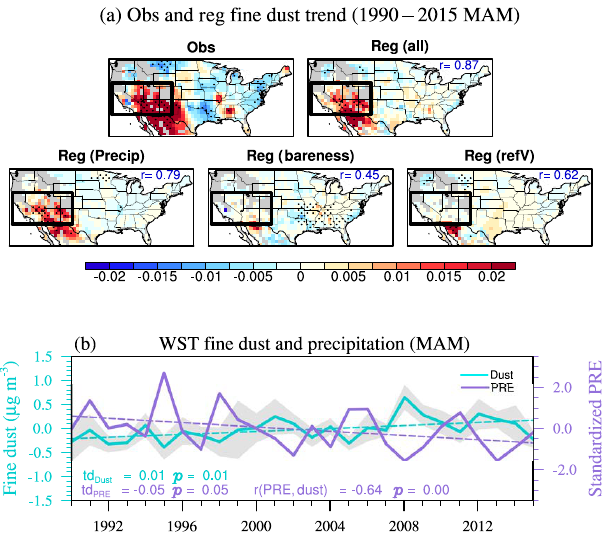
Figure 3. (a) Observed (Obs) and reconstructed (Reg) trends of fine dust concentration (µgm − 3 ) using three factors in spring from 1990 to 2015. The contributions from each factor (precipitation, bare- ness, and surface wind) to the overall reconstructed trend are also shown (second row). Dotted areas are significant at the 90% con- fidence level. Pattern correlation between reconstructed dust con- centration trends and observed trends in the domain (25–49.5 ◦ N, 66.5–125 ◦ W) are shown at the top right corner of each plot. The black box denotes the southwestern US (WST). (b) Time series of fine dust concentration (cyan) and precipitation (purple) averaged over the WST and their linear trends (dashed lines; values are listed at bottom left) in spring from 1990 to 2015. Grey shading denotes ± 1 standard error of the observations. The correlation between fine dust and precipitation is also listed at the bottom in